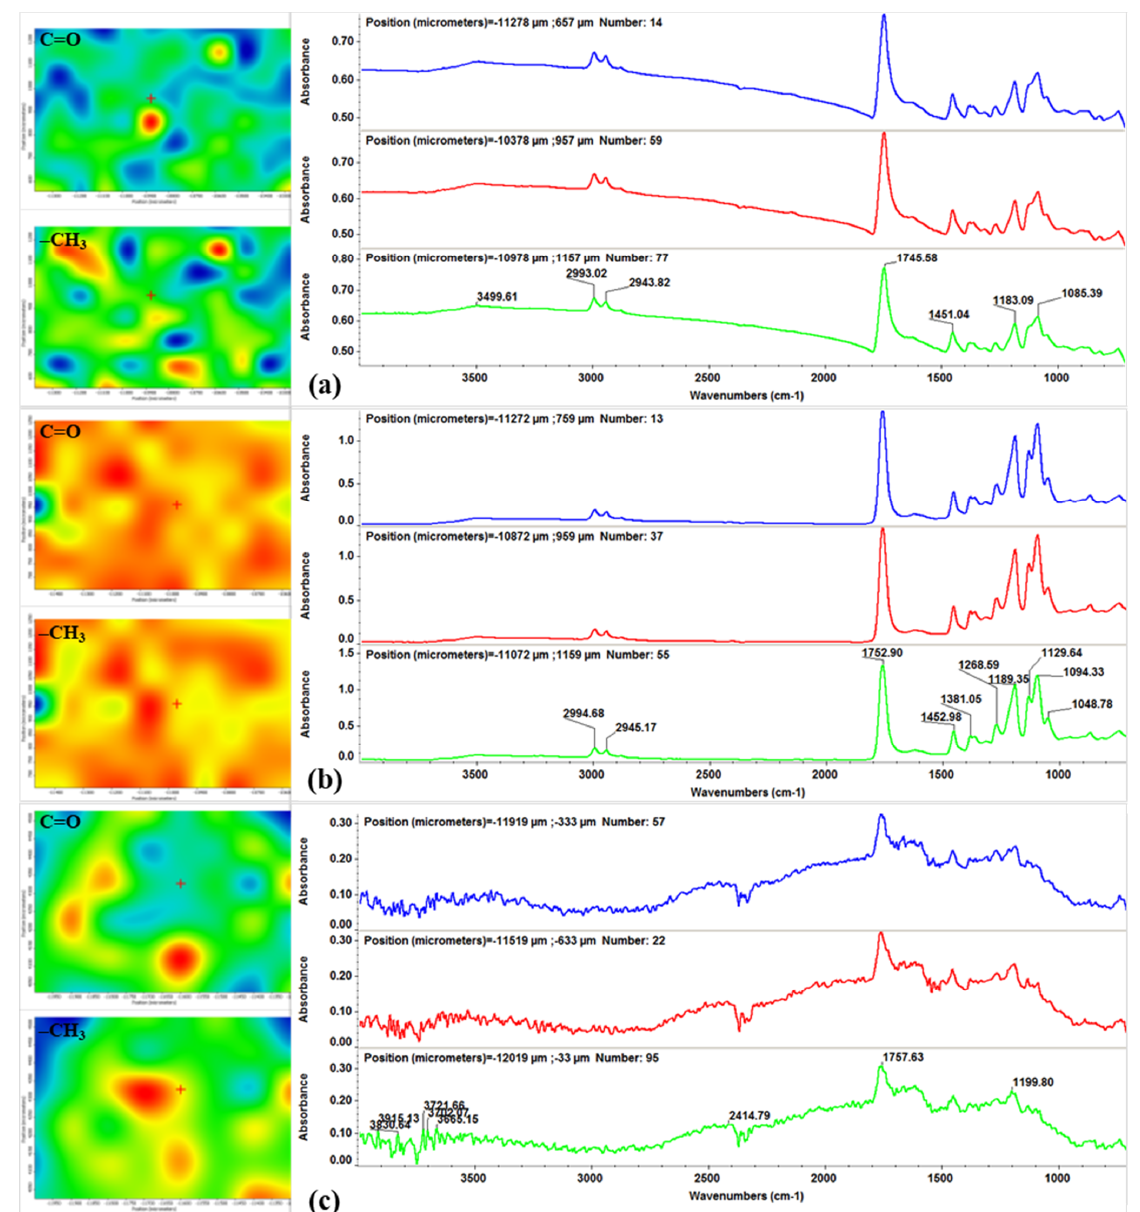
Figure 8. IR maps (left ) and corresponding IR spectra ( right ) of PLA/Fe 3 O 4 @EG coatings processed by matrix-assisted pulsed laser evaporation (MAPLE) at 200 mJ/cm 2 ( a ), 300 mJ/cm 2 ( b ) and 400 mJ/cm 2 ( c ). The infrared data confirm that composite coatings containing PLA and iron oxide nanoparticles conjugated with EG essential oil were successfully obtained. In terms of chemical integrity and efficient material transfer, the middle laser fluence (300 mJ/cm 2 ) was experimentally identified as the optimal choice for the MAPLE synthesis of PLA/Fe 3 O 4 @EG coatings. Therefore, composite materials for further characterization (SEM investigation) and cellular evaluation (biological and microbiological assays) were obtained only by using this particular value of laser fluence.